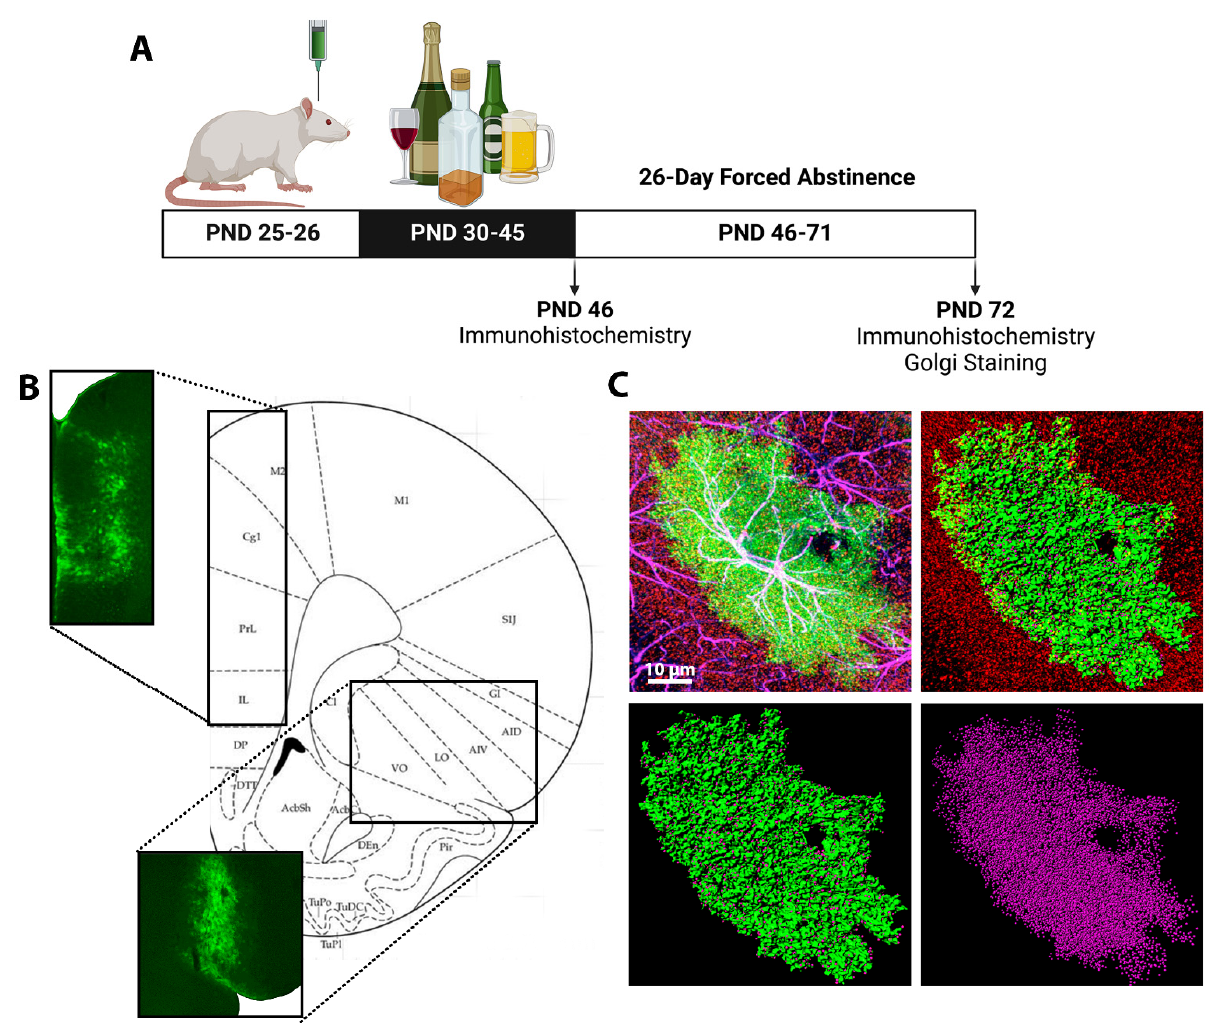
Figure 1. Experimental Design: ( A ) Animals received intracranial injections of an astrocyte-specific adeno-associated virus directly into the ACC, mPFC, or OFC on PND 25–26. Beginning PND 30, animals received 5 g/kg of EtOH or water via oral gavage on an intermittent, 2 days on, 1 day off, 2 days on, 2 days off, schedule. Tissue was collected on PND 46, during peak withdrawal, or after a 26-day forced abstinence period, on PND 72. ( B ) Validation of Lck-GFP expression in the ACC and mPFC (upper left image) and the OFC (bottom image). ( C ) Representative images of AAV+ astrocyte imaging with confocal microscopy and reconstruction using Imaris. The top left image is a confocal image of an AAV+ astrocyte (green), with GFAP (magenta), co-localization of AAV+ and GFAP (white), and PSD-95 (red), scale bar, 10 μ m. The top right image is a reconstructed astrocyte (green) and PSD-95 (red). The bottom left image is a reconstructed surface rendered astrocyte (green) with PSD-95 (magenta) within 0.5 μ m of the astrocyte. The bottom right image is isolated PSD-95 (ma- genta) that is colocalized with the astrocyte of interest. 2.2. Intermittent Binge EtOH Exposure Prior to EtOH/water (H 2 O) exposure, animals were habituated to handling. Begin- ning PND 30, animals were exposed to EtOH or H 2 O consisting of 10 doses of 5 g/kg EtOH (35 % v / v in H 2 O) or H 2 O by intragastric gavage (i.g.) using 2 days on, 1 day off, 2 days on, 2 days off intermittent schedule of 16 days (Figure 1A), as previously described in Risher et al., 2015 [52]. While all experimenters were blinded, this is difficult to maintain during EtOH administration due to the strong smell of EtOH. The experimenter that administers the EtOH is also responsible for ensuring that the animals recover from intoxication, once